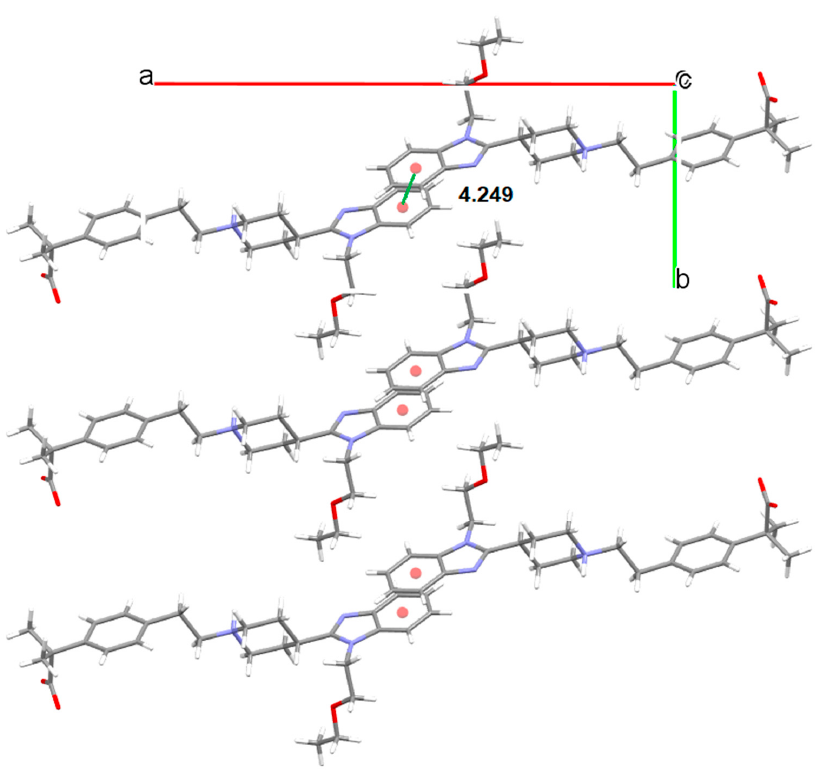
Figure 10. π - π stacking (centroid–centroid distance in Å) observed in Form I of Figure 10. π−π stacking (centroid–centroid distance in Å ) observed in Form I of BL. Attempts to grow quality crystals of forms II and III were unsuccessful. Crystals of form III were grown and observed under the microscope. The extinction of a crystal is observed in Figure 11; however, it was impossible to cut the extreme of this crystal in